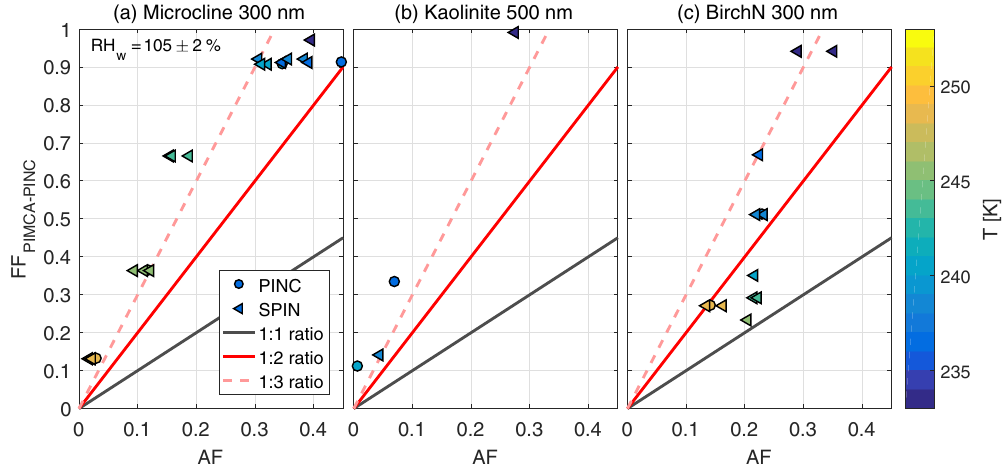
Figure 10. Scatter plot of the FF (immersion freezing) and AF (condensation freezing) showing discrepancies between the instruments. Lines show the 1 : 1, 1 : 2, and 1 : 3 ratios (black, red, and pink, respectively) for three different aerosol types. PINC and SPIN data are binned by an RH w of ±